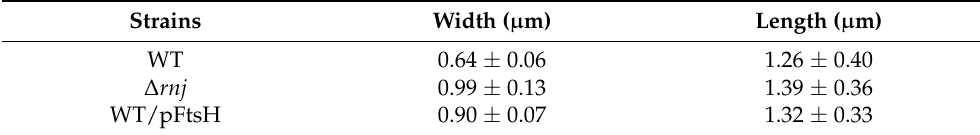
Table 1. Cell dimension of corynebacterial